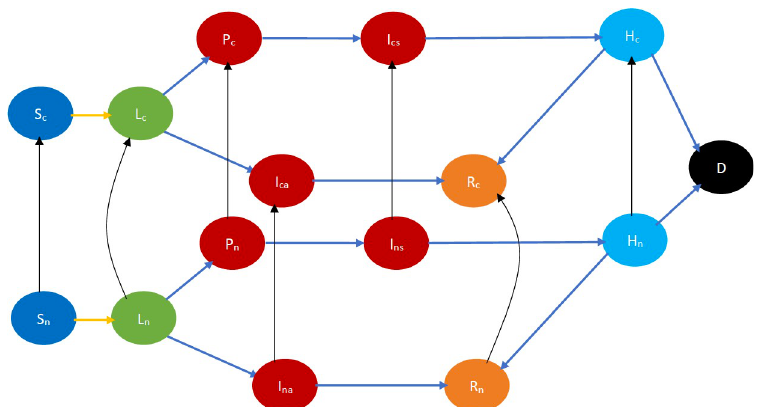
Fig 20. COVID-19 state diagram. The symbol S denotes susceptibles, L denotes individuals in the latent stage, P denotes symptomatic stage, I denotes asymptomatic stage, H stands for hospitalized, R stands for pre-symptomatic, I s a denotes recovered, and D stands for dead. The suffixes c and n respectively stand for cooperatives and non- cooperatives e.g., S and S denote cooperative and non-cooperative susceptible individuals respectively. Similarly, I c n and I stand for cooperative asymptomatic and non-cooperative asymptomatic individuals na